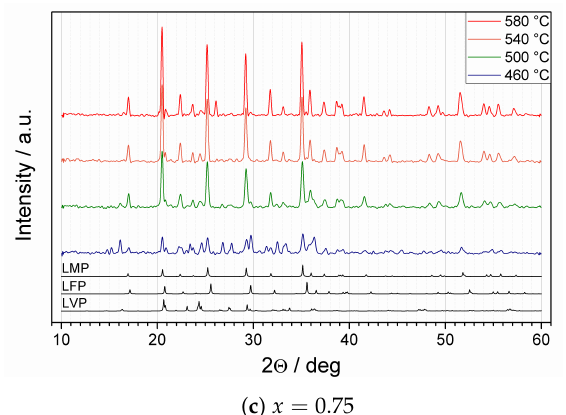
Figure 3. Temperature-dependent XRD patterns for Li(Fe 1 − x Mn x ) 0.88 V 0.08 PO 4 samples upon heating to 580 °C in nitrogen flow. Reference patterns for LiFePO 4 (LFP), LiMnPO 4 (LMP), and Li 3 V 2 (PO 4 ) 3 (LVP) are given below. Figure (b) reproduced from Ref. [12] by permission of IOP Publishing. ©